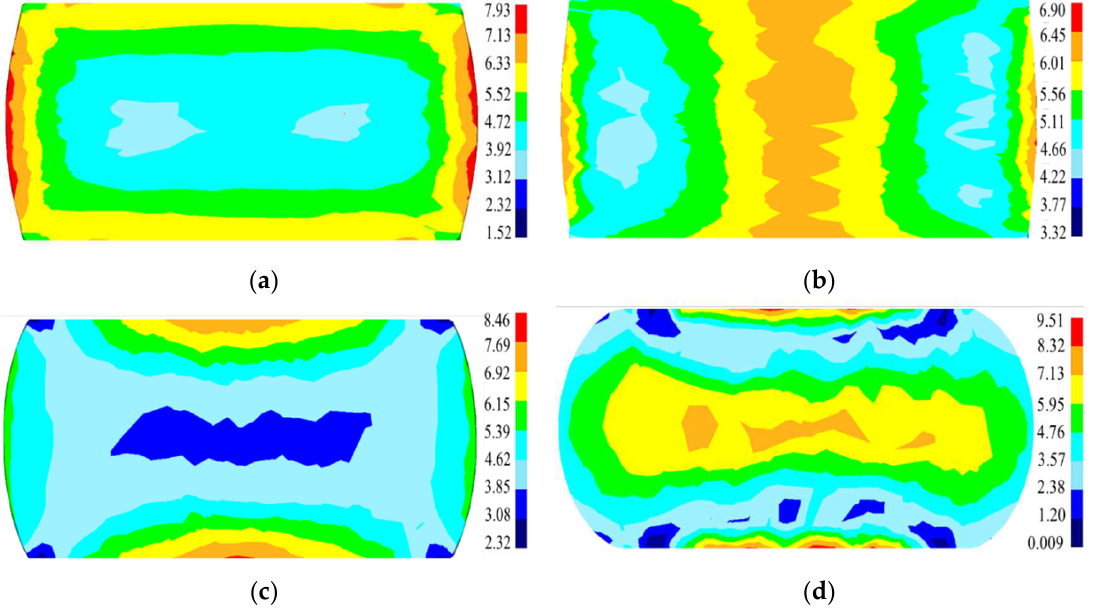
Figure 23. The distribution of the simulated grain size at ( a ) 1110 °C/0.1 s −1 ; ( b ) 1140 °C/0.1 s −1 ; ( c ) 1110 °C/0.01 s −1 ; and ( d ) 1110 °C/1 s −1 .